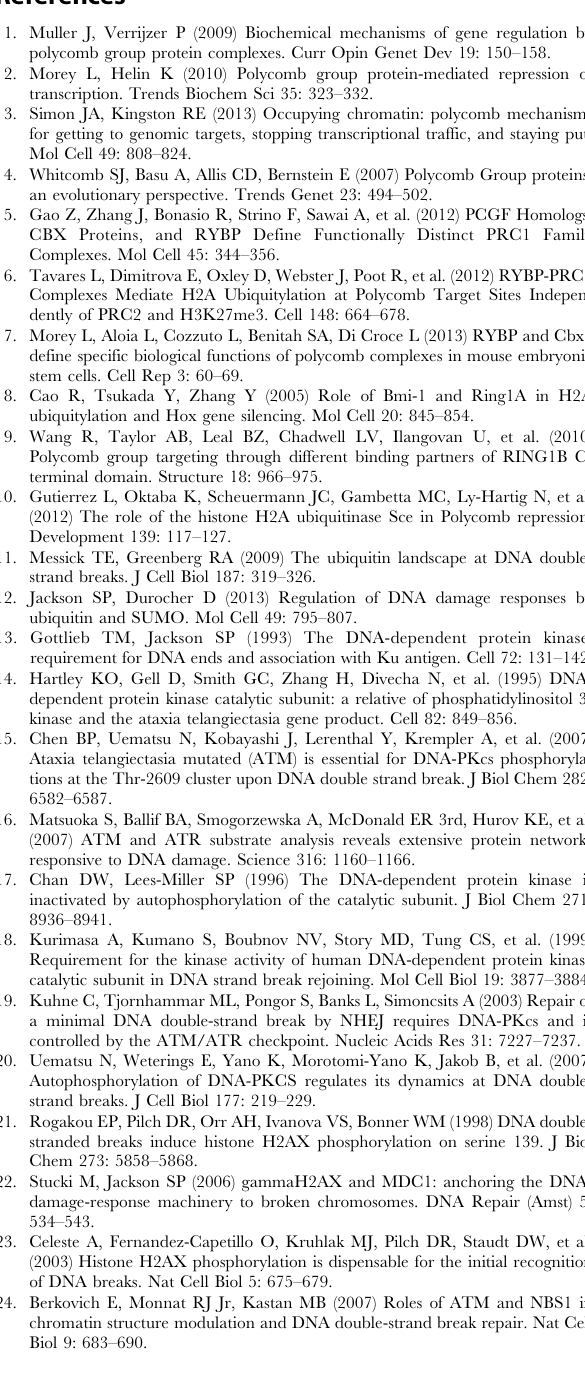
Table S3 List of Asi SI sites at which a pDNA-PKcs peak was detected in OHT-treated